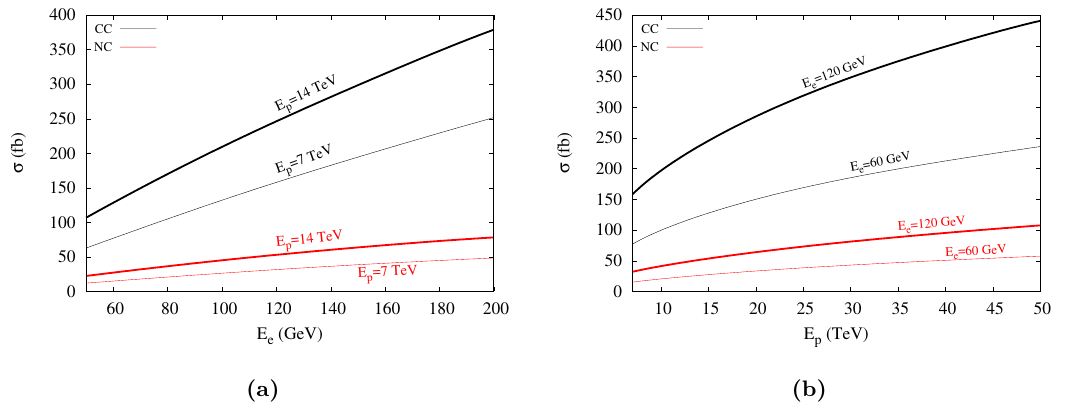
Figure 2 . Variation of CC (black) and NC (red) cross sections with respect to the electron beam energy, E e (left), and proton beam energy, E p